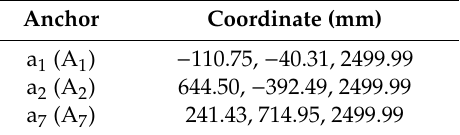
Table 4. The coordinate of anchors in